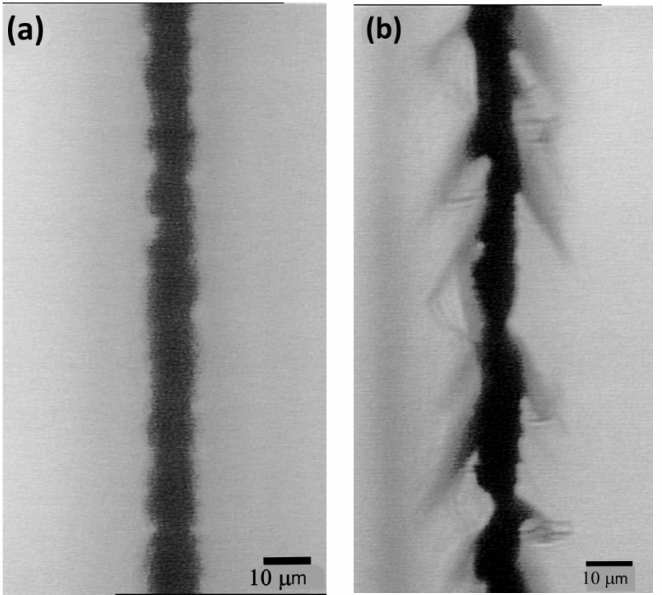
Figure 2. Optical images of buried electrodes formed by laser pulses of different duration: ( a ) 330 fs, ( b ) 8 ns.